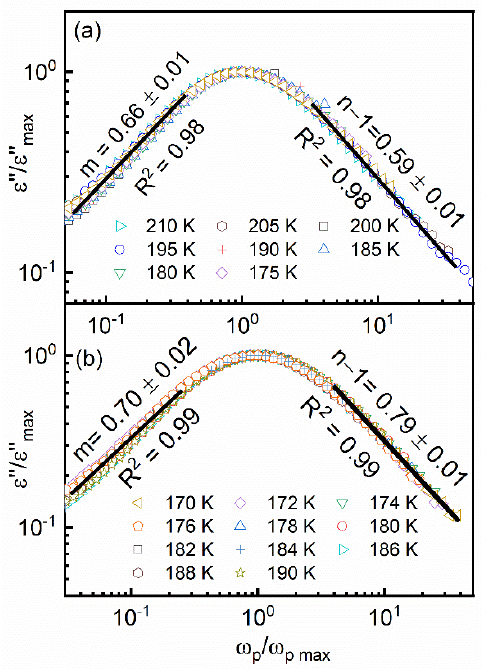
Figure 7. Normalized dielectric loss data obtained for DMAZnF ( a ) and DMAZnD ( b ) (log–log scale). Straight lines show linear fits to data points. For both the samples, the value of the high ( n − 1) -and low-frequency (m) power − law exponent remained temperature invariant.